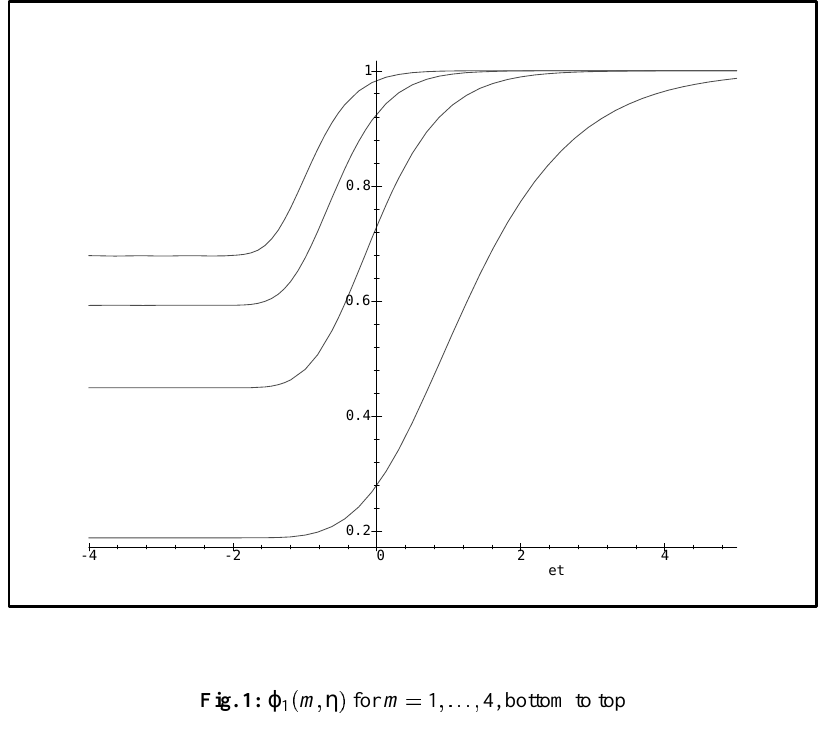
Fig. 1: j 1 (cid:0) m